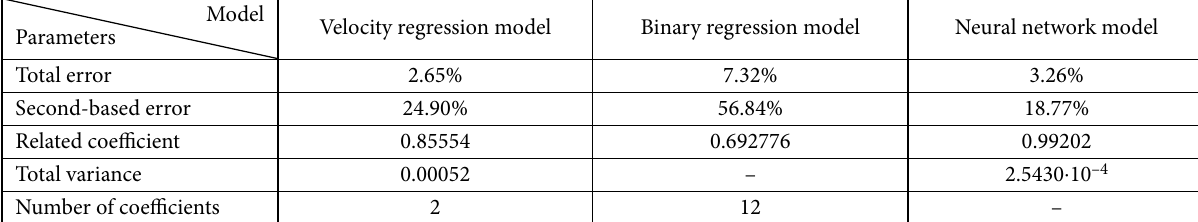
Table 6. NO x emission model error analysis